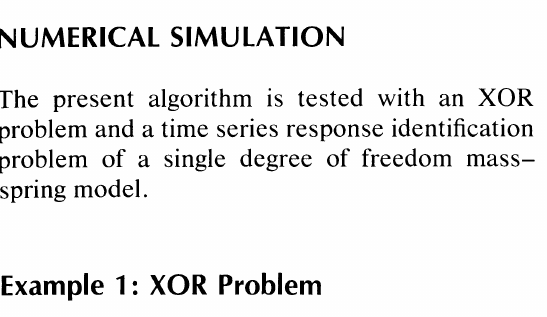
FIGURE 2 History of absolute error of XOR